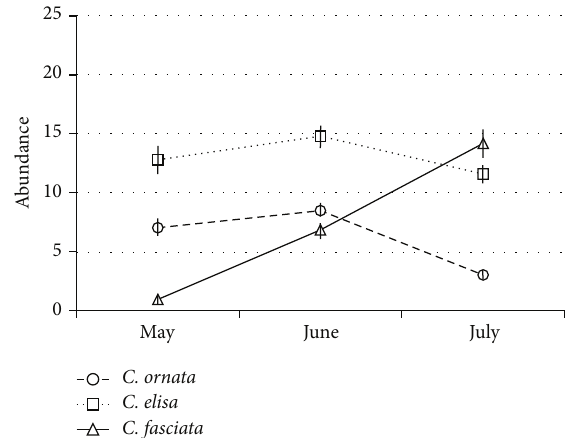
Figure4:Monthlychangesinthehourlyabundancecounts( 𝑋± SE), for Celithemis ornata, C. elisa , and C. fasciata at Ashmore Heritage Preserve, Greenville County, SC, USA, from May to July 2015.